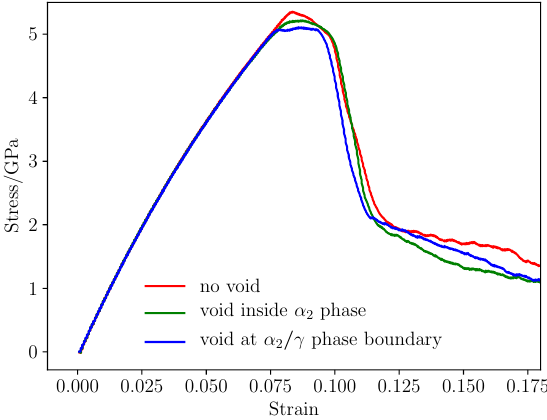
Figure 9. Stress-strain response of the materials under tensile